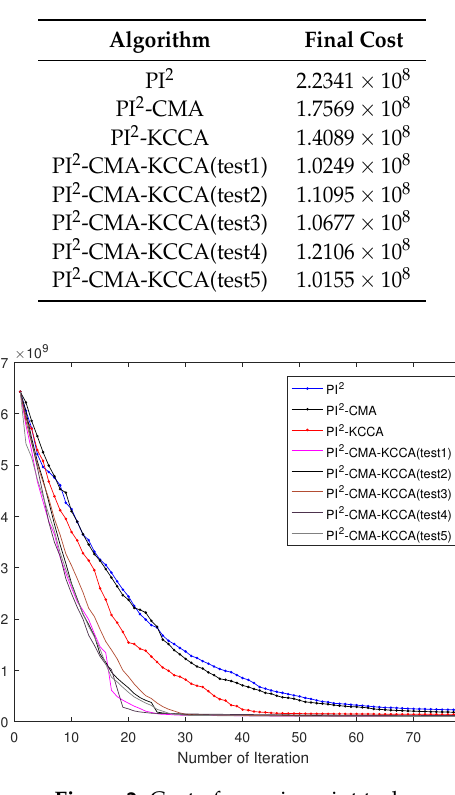
Figure 2. Cost of one via-point